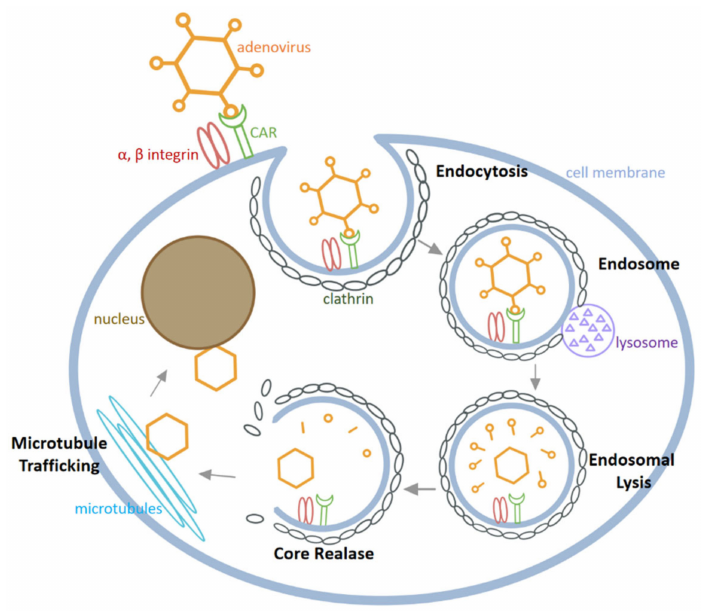
Figure 3. The process of HAdV infecting